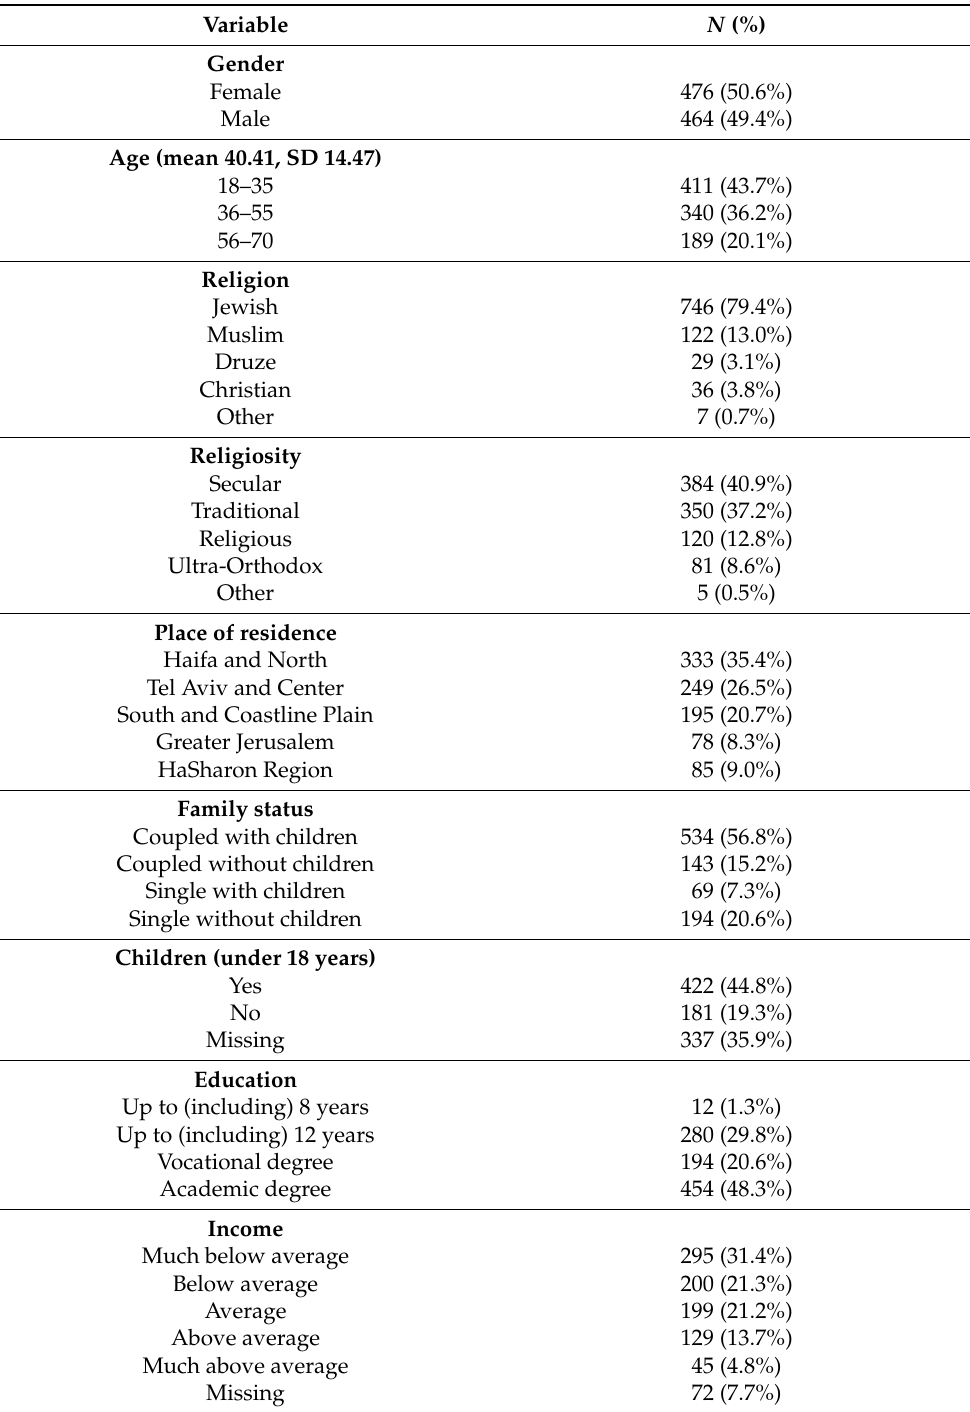
Table 1. Sociodemographic distribution of the studied